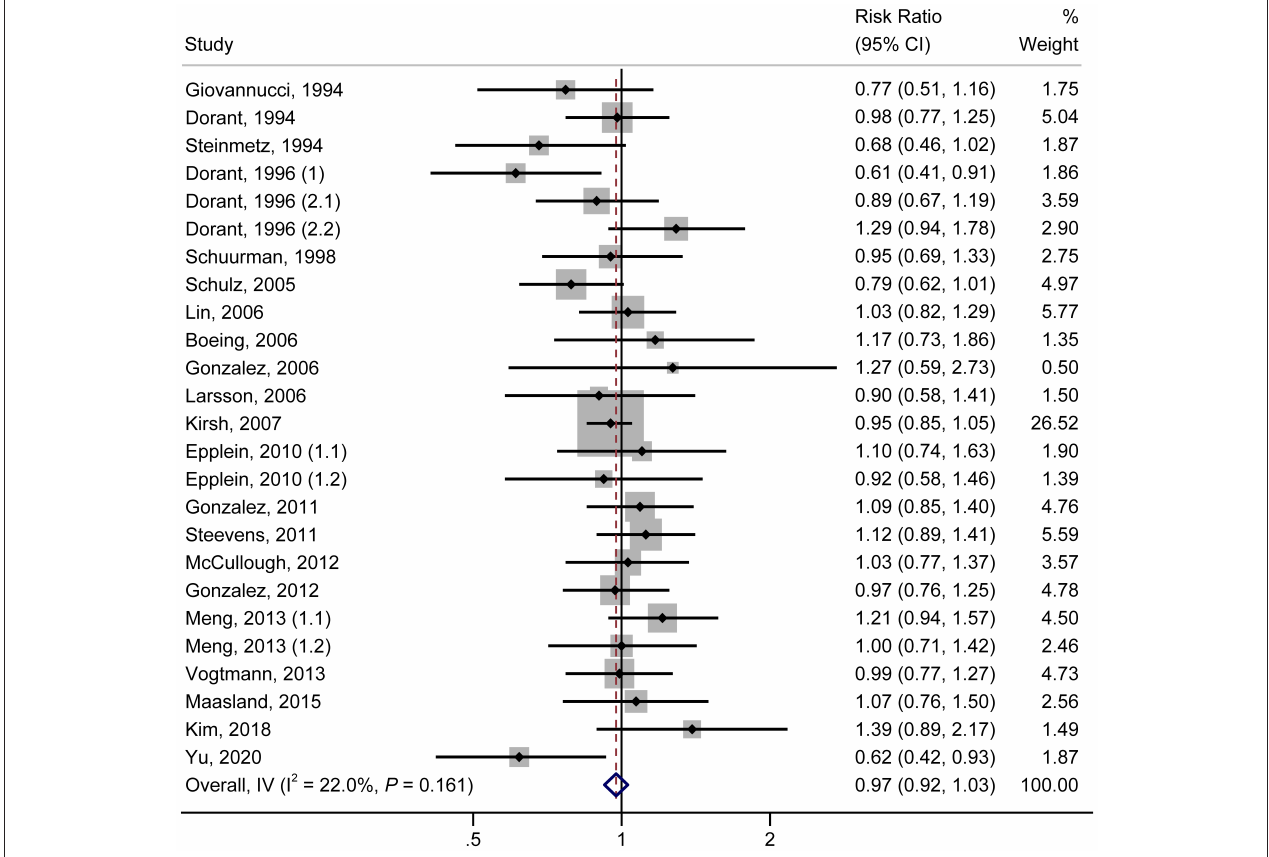
FIGURE 1 | Forest plot of the association between allium vegetable consumption and cancer risk (highest vs. lowest category of allium vegetable consumption).